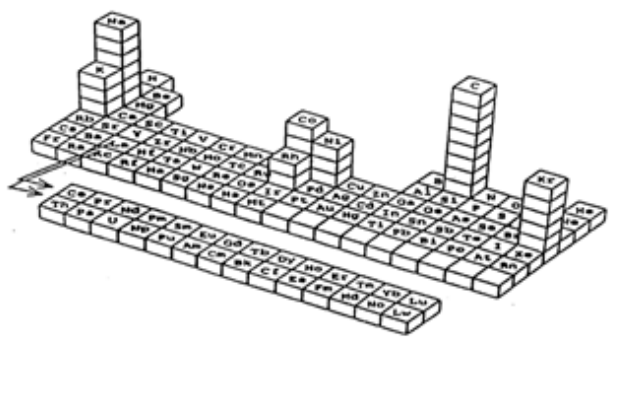
Figure 1. 3D-Periodic table of